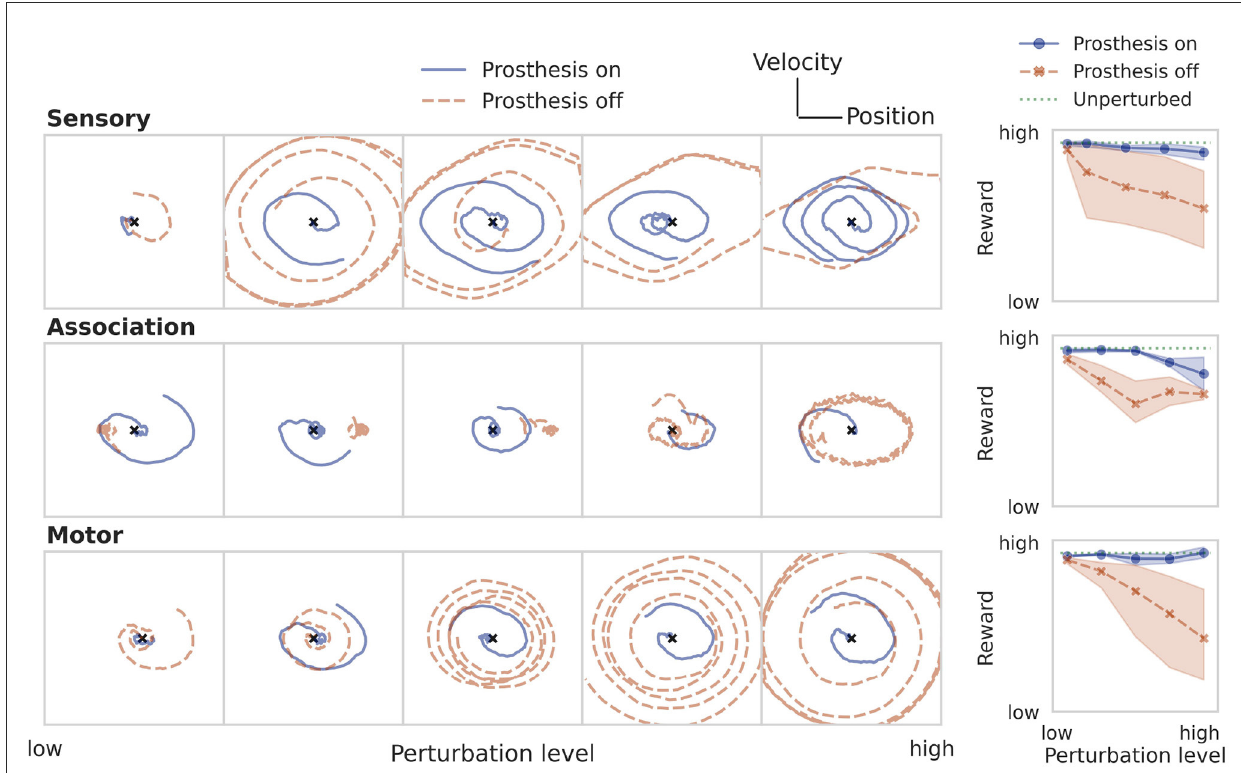
FIGURE6 Restoring particle stabilization performance by training a prosthetic controller using RL. See caption of Figure 5 for a more detailed